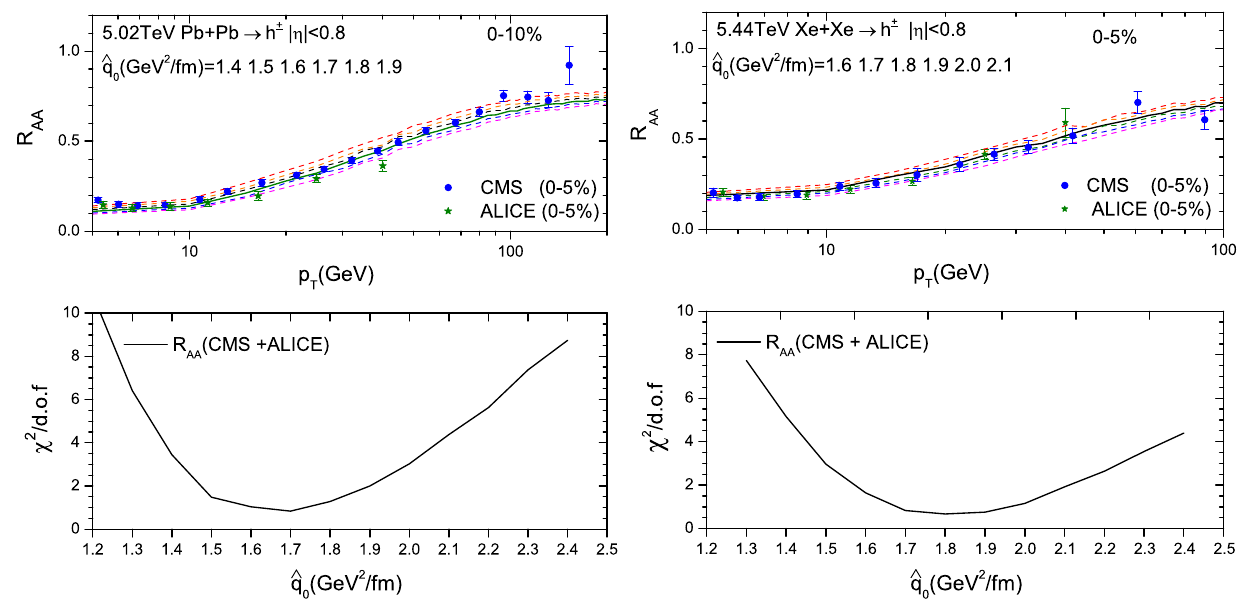
√ s NN = 5 . 02TeVandincentralXe+Xecollisionsat